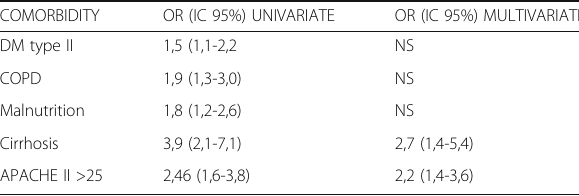
Table 14 (abstract A19). Relation between comorbidities and